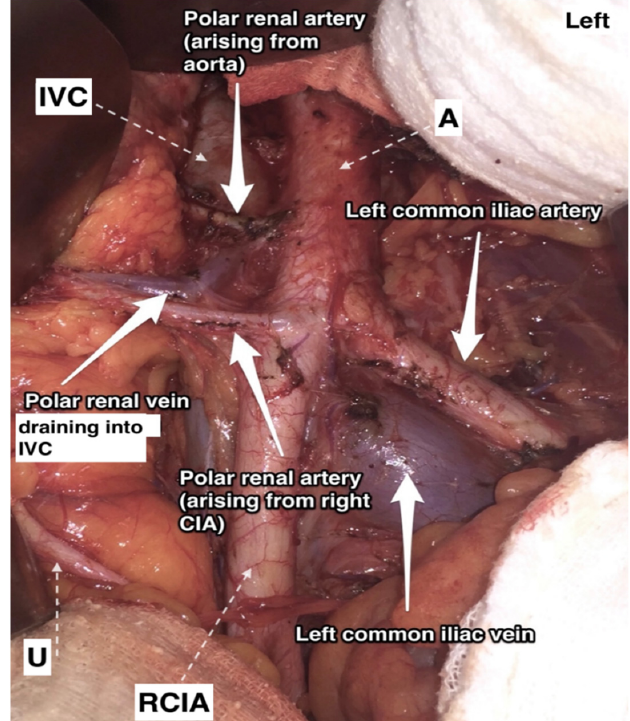
Figure 9. Additional right aortic upper polar renal artery and accessory right aortic lower polar artery arising from the abdominal aorta and the right common iliac artery, respectively. The arteries have a precaval course (open surgery performed by doctor Ilker Selcuk). IVC—inferior vena cava, A—abdominal aorta, U—right ureter, RCIA—right common iliac artery.